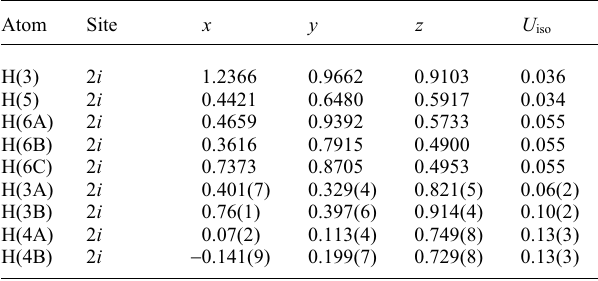
Table 2. Atomic coordinates and displacement parameters (in Å 2 )